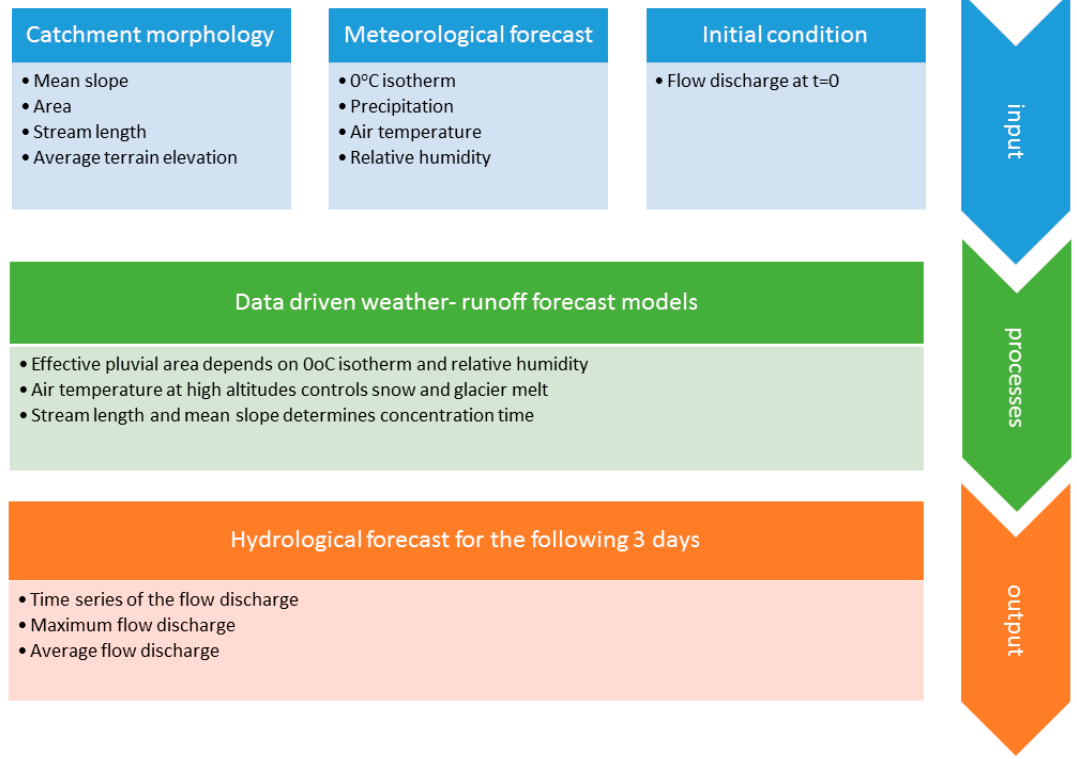
Figure 4. Flow-chart for the data-driven weather-runoff forecast models.